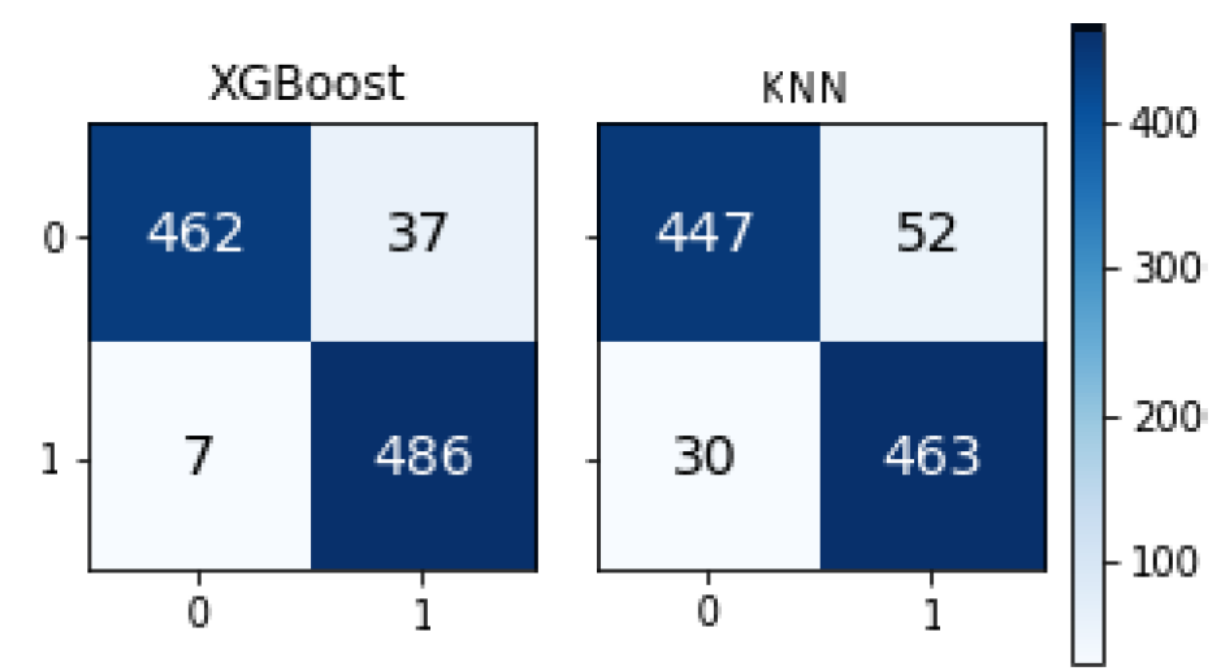
Figure 11. Confusion matrices of machine learning algorithms.